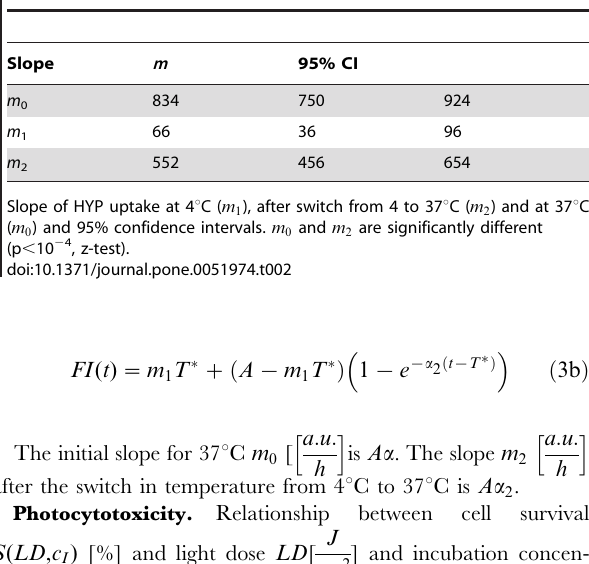
Table 2. Cellular HYP uptake rates m